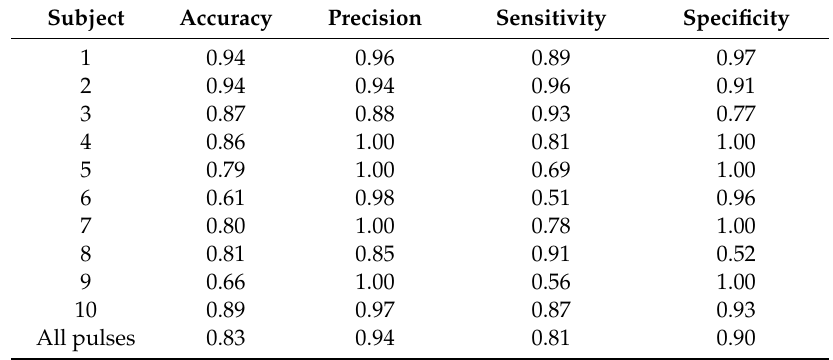
Table 7. The statistic results for the PPG pulses with the high SQIs for the individual subject and the total